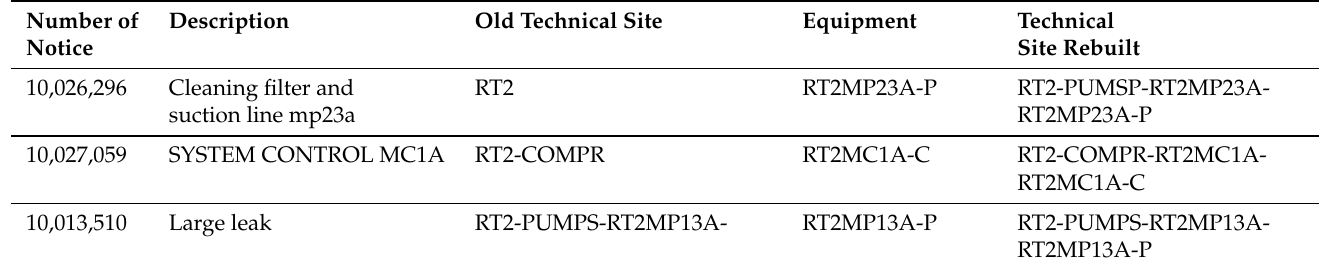
Table 2. Examples of reconstruction data with the first methodology.